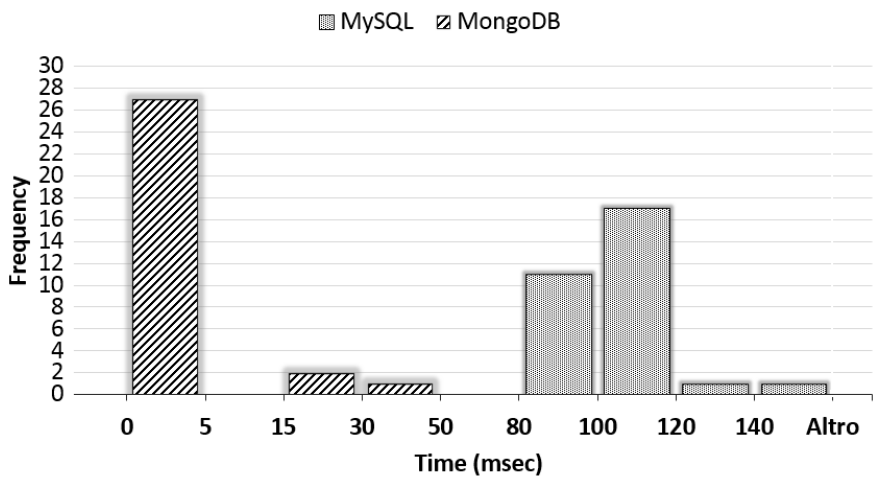
Figure 14. Insertion frequency histogram of documents and records respectively in MongoDB and MySQL.